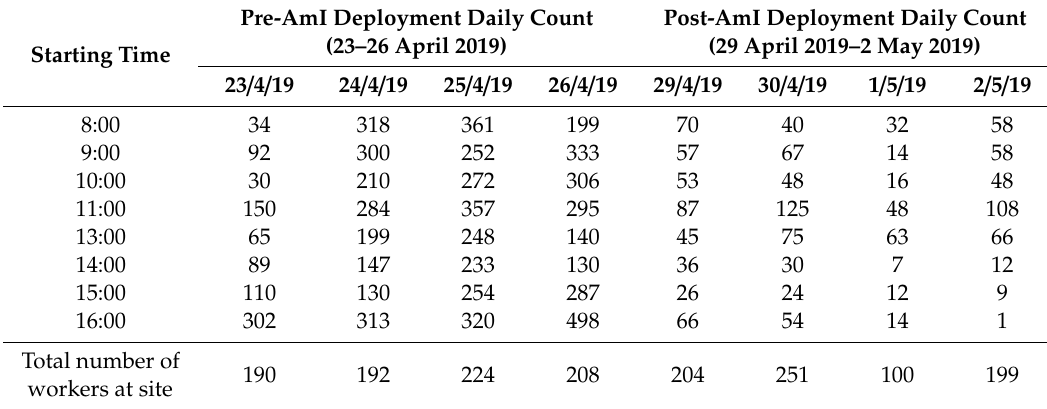
Table 2. Daily count data from the pre- and post-AmI deployment stages.